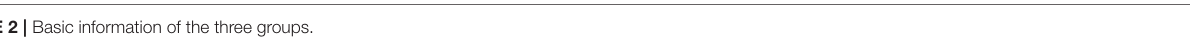
TABLE 2 | Basic information of the three groups.